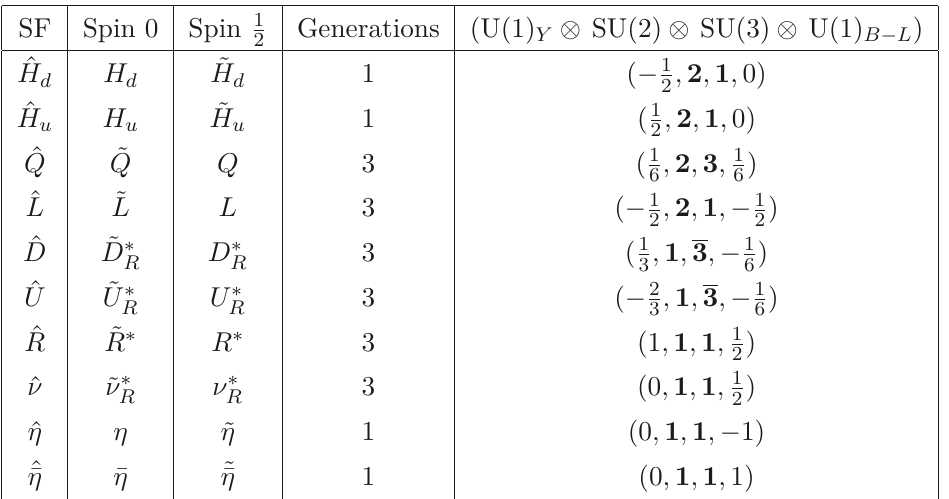
Table 1 . The quantum numbers of fields in the